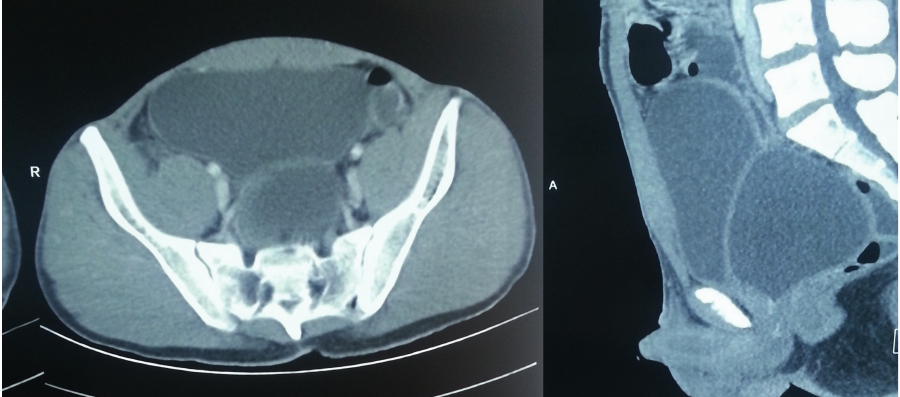
figure 2 - preoperative cT scan showing the bladder anteriorly and prostatic utricle cyst